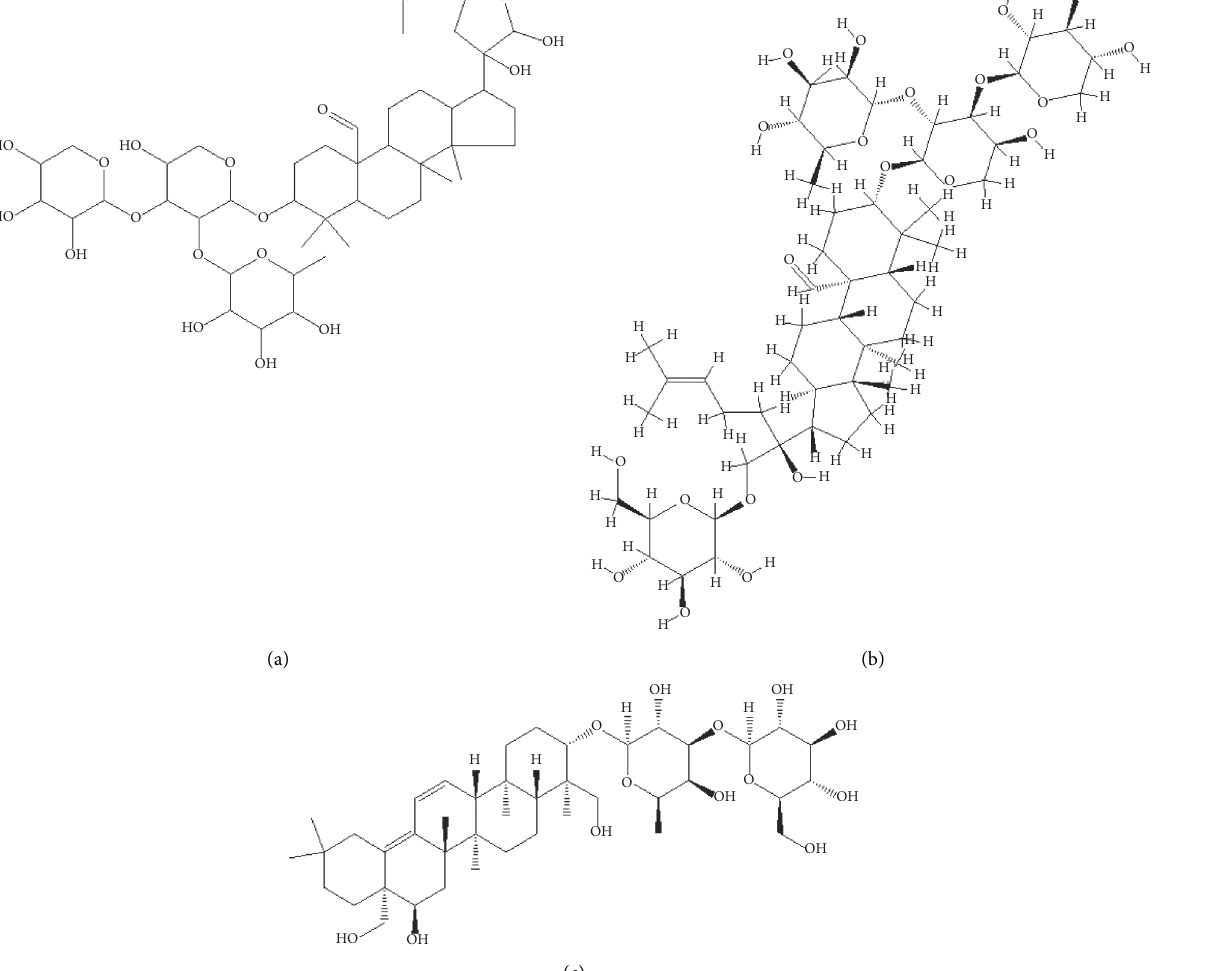
Figure 1: Chemical structure of gypenoside A (a), gypenoside XLIX (b), and saikosaponin B2 (c), the internal